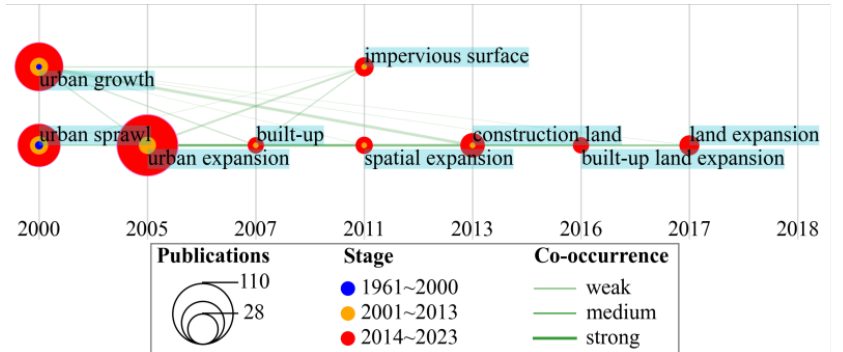
Figure 6. Development of “keywords of urban expansion”.